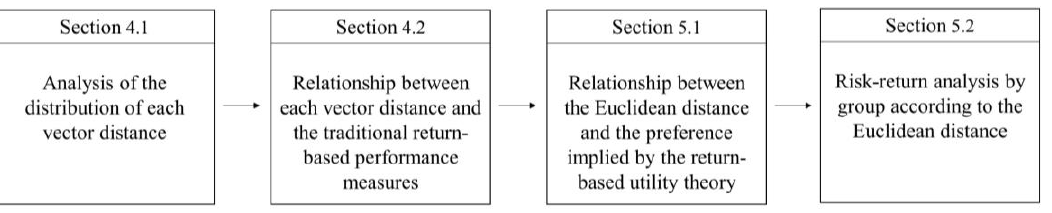
Figure 2. An outline of the